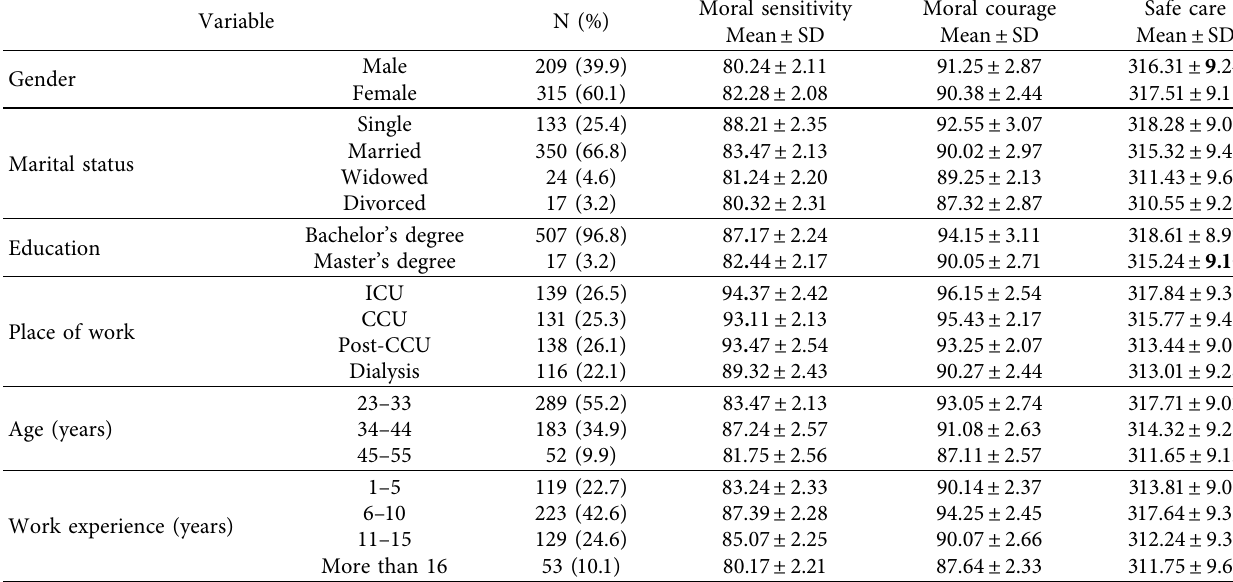
Table 1: The demographic characteristics, moral sensitivity’ scores, moral courage’ scores, and safe care’ scores based on the demographic